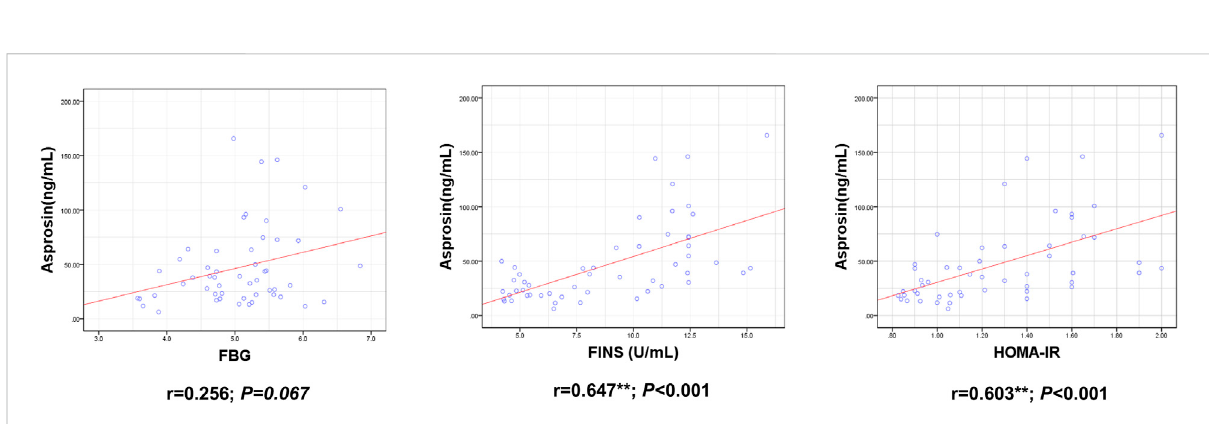
FIGURE 4 Correlation between Serum asprosin and glucose metabolism related indexes. r-correlation coef fi cient, p < 0.05 — level of statistical signi fi